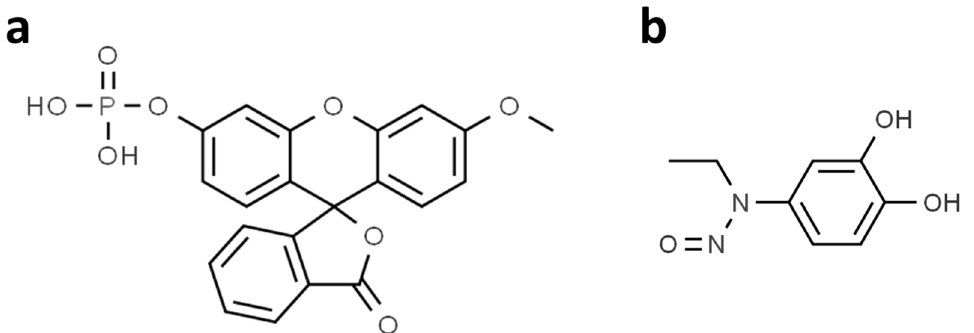
Figure 1. Structure of phosphatase substrate and phosphatase inhibitor used to analyze DUSP22 activity. ( a ) Structure of 3-OMFP, a substrate for DUSP22. ( b ) Structure of ethyl-3,4-dephostatin, an inhibitor of DUSP22 activity.